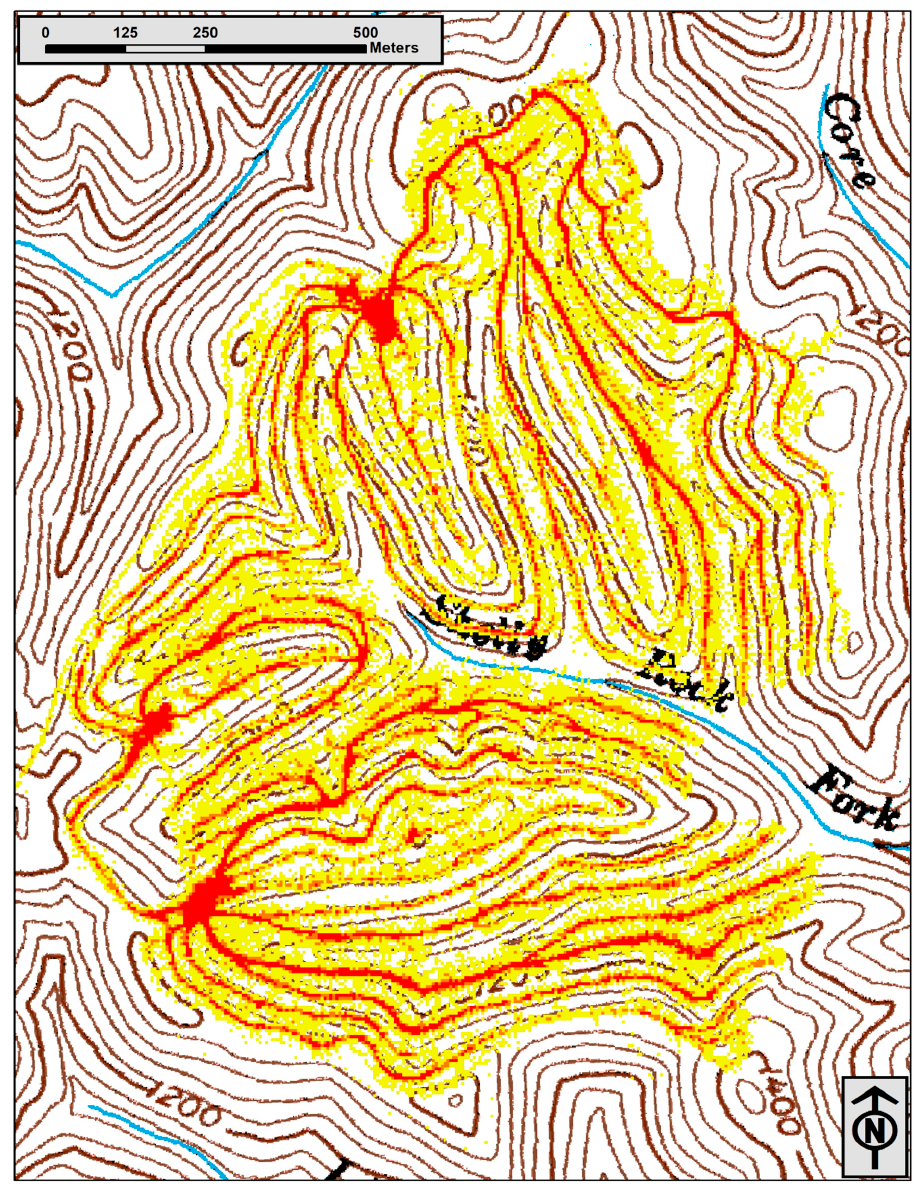
Figure 2. Raster map showing relative tra ffi c intensity for all harvest machines on the three study watersheds. Yellow cells are least tra ffi cked, orange are more tra ffi cked, and red are the most tra ffi cked skid trail